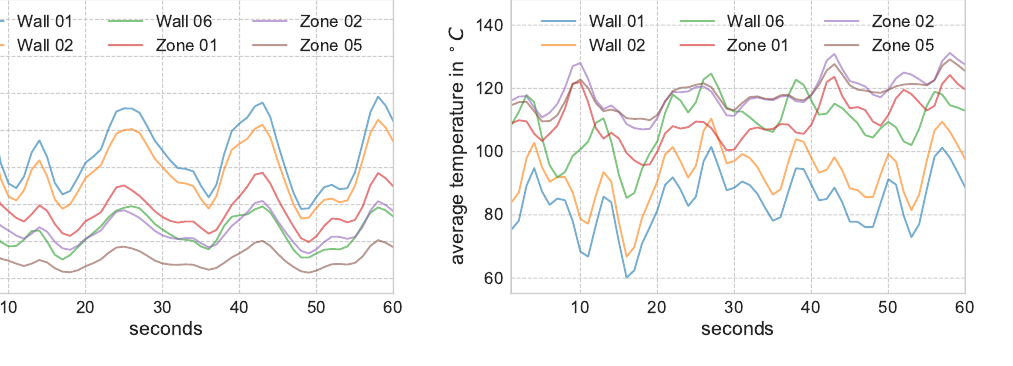
(a) Average temperature of zones from raw measurements ( RM ). (b) Average temperature of zones based on Linear equation using